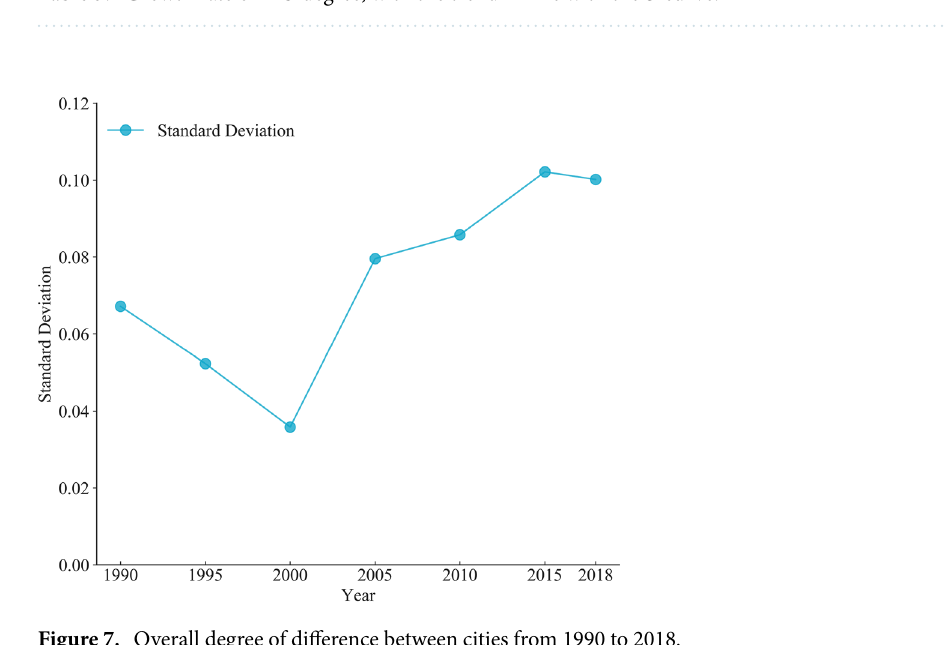
Figure 7. Overall degree of difference between cities from 1990 to